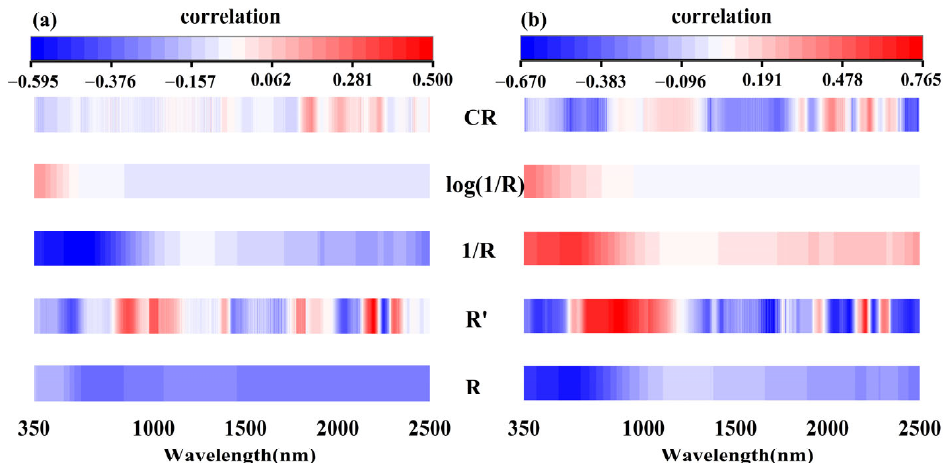
Figure 6. Statistical map of soil particle diameter in coastal wetlands. ( a ) Statistical results of soil particle diameter: D n represents the particle diameter corresponding to n% of the soil; µ g ( q 0 ) represents the geometric average of soil particle diameter; ( b ) Particle diameter distribution in silty soils; ( c ) Particle diameter distribution in sandy soils.